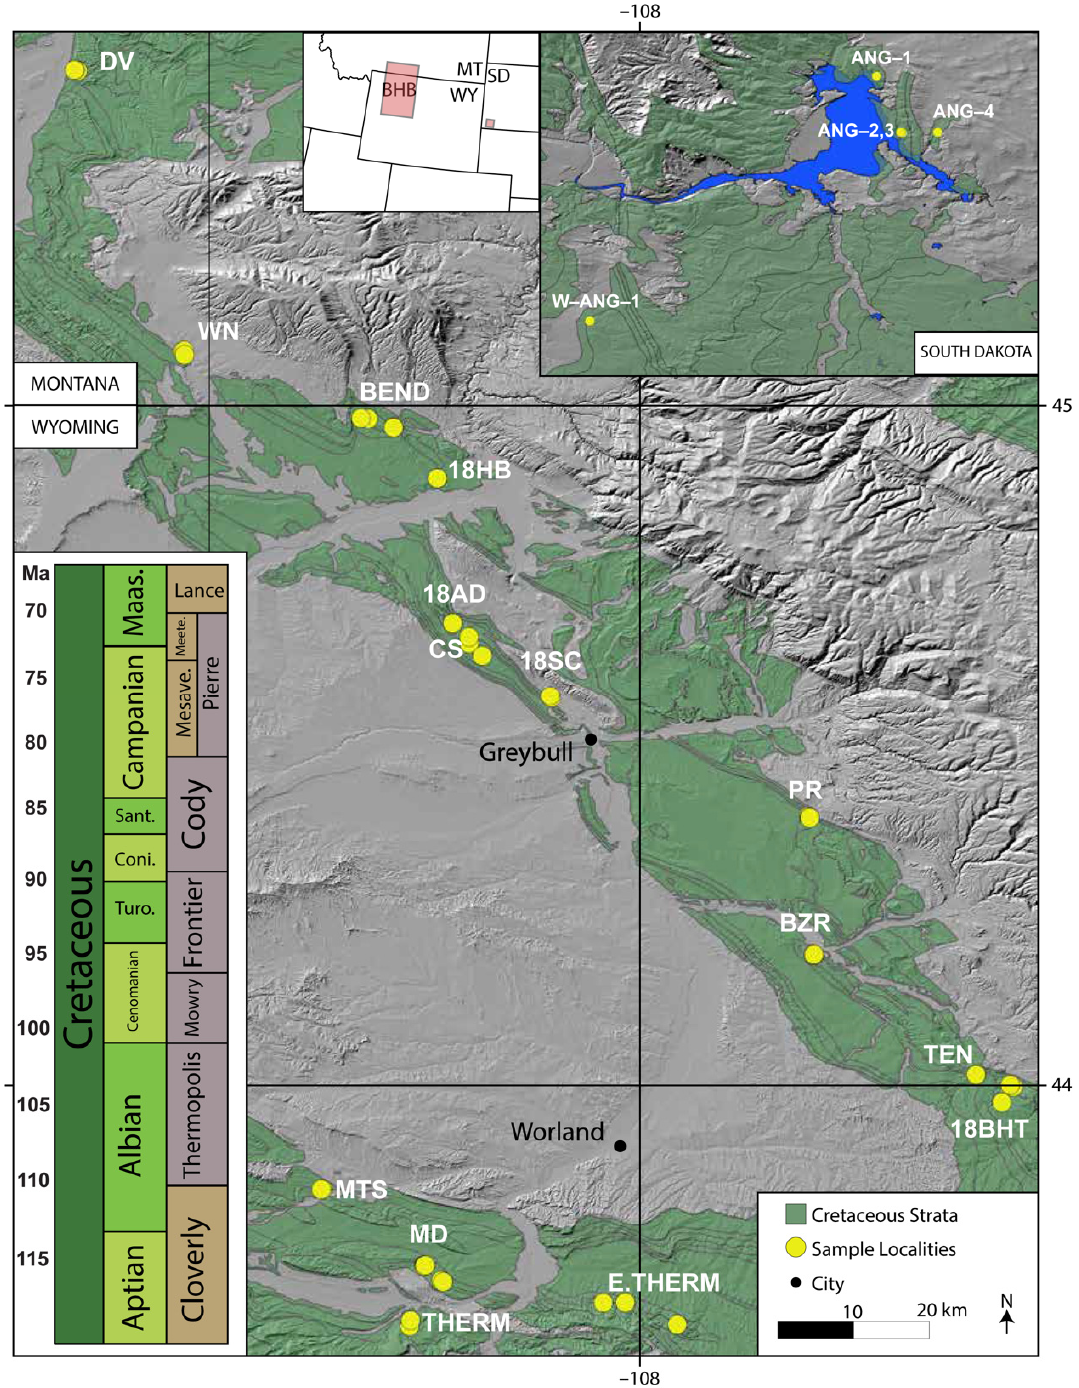
Figure 2. Map of the Bighorn Basin and southwestern South Dakota (top right inset). Green shading is Cretaceous strata; yellow circles are the sampling localities. Bottom left inset shows the regional stratigraphy for northwestern Wyoming. Modified from [11].